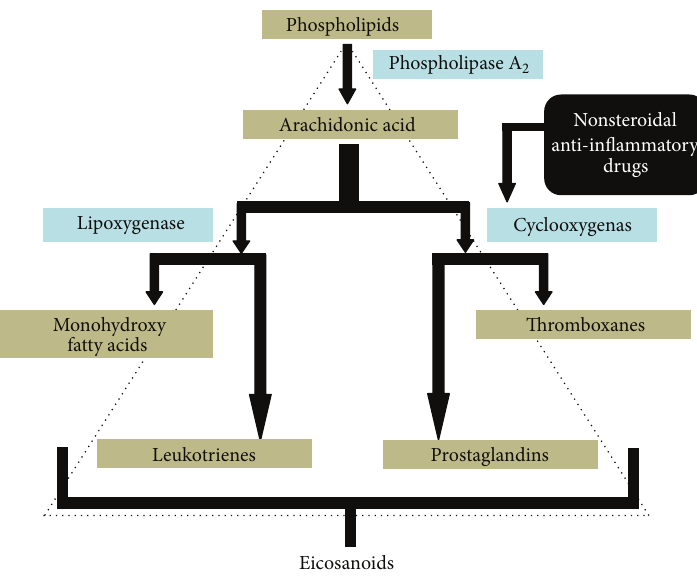
Figure 1: Schematic representation of inhibition of prostaglandin synthesis by NSAIDs.